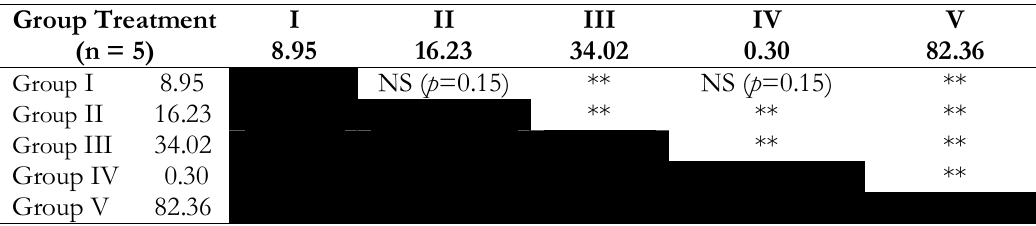
Table II : Result of Tukey HSD test of mean duration time of reppllency effectivity citronella oil lotion to Aedes